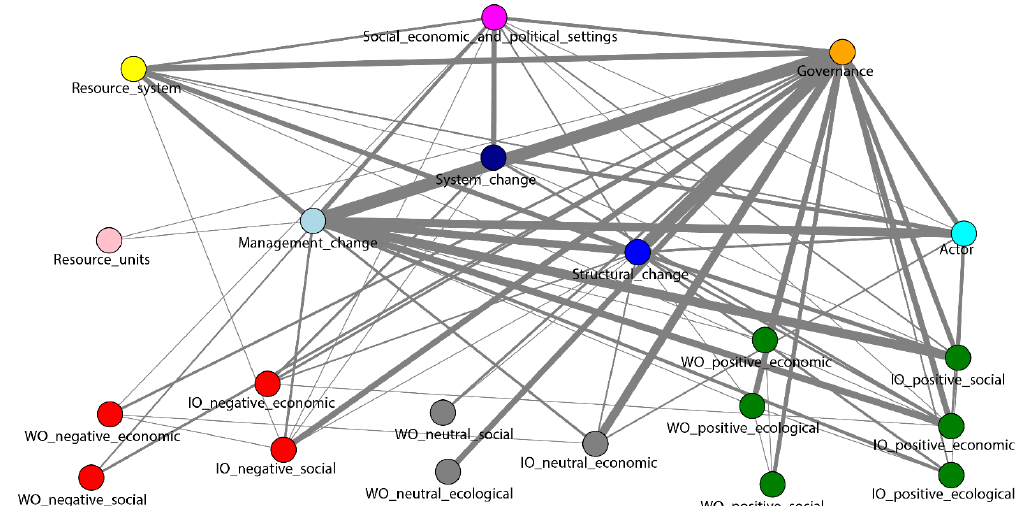
Figure A1.5. Vermont SES Category group mental model network